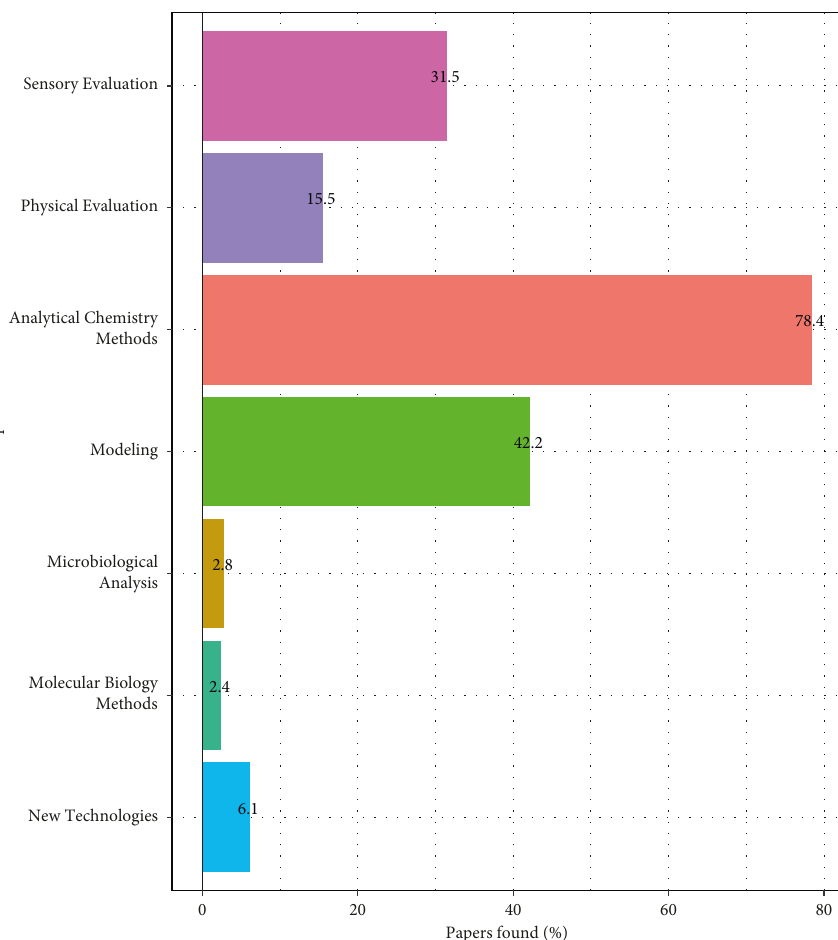
Figure 5: Percentage of the articles classified by the technique of quality